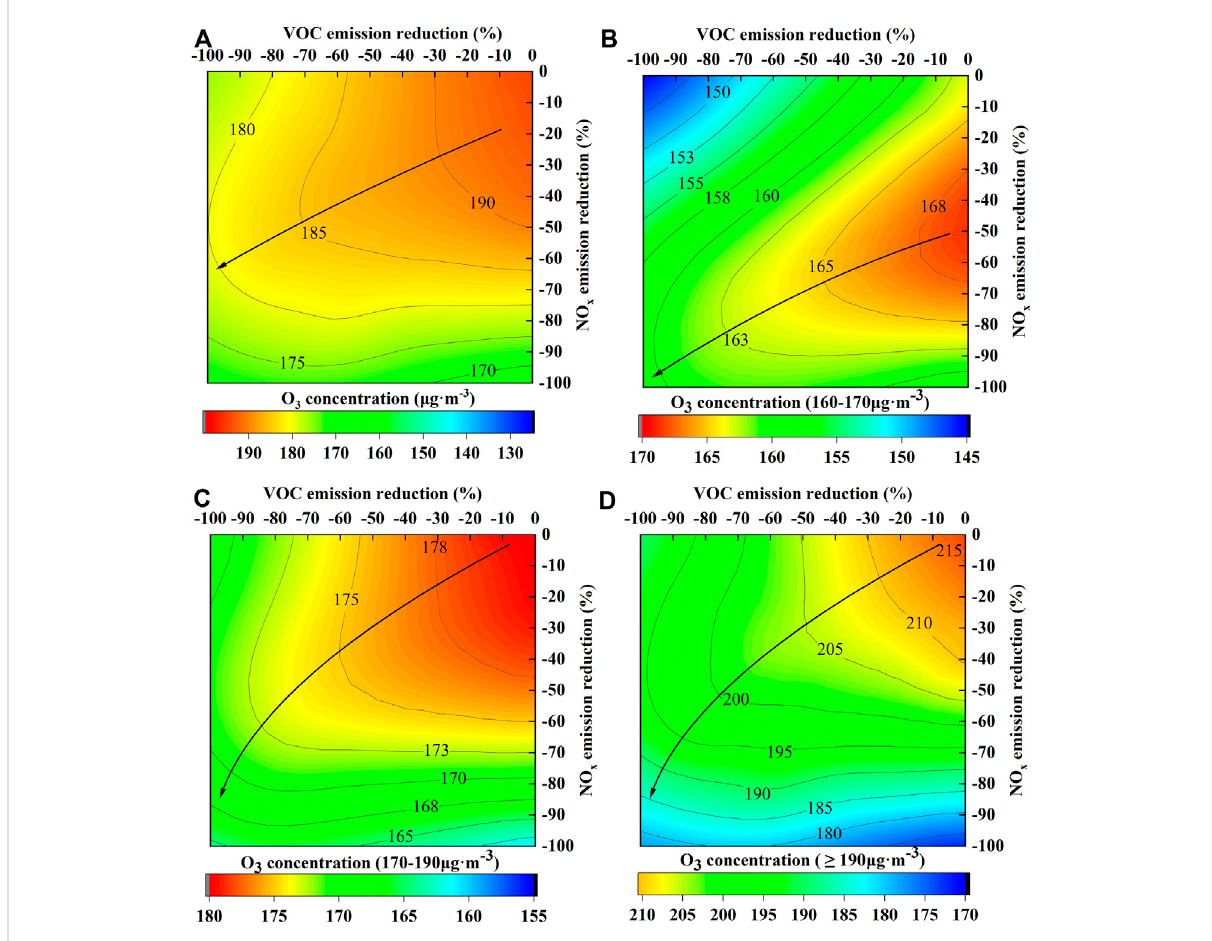
FIGURE 4 Isopleth diagrams of MDA8 O 3 varing with VOCs and NO x emission reductions in Chengdu for (A) all polluted days, (B) polluted days with MDA8 O 3 concentrations in the range of 160 – 170 μ g m − 3 , (C) polluted days with MDA8 O 3 concentrations in the range of 170 – 190 μ g m − 3 and (D) polluted days with MDA8 O 3 concentrations greater than 190 μ g m − 3 (the black arrows are